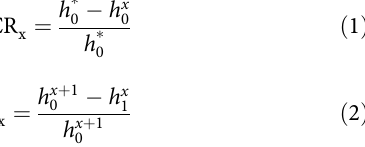
(CR) and the elastic modulus after relaxation ( E relax ). The CR is directly calculated from the difference in pellicle thickness ( h ) at each compression pro fi le compared to the starting thickness ( h 0 * ) (Eq. 1). E relax is computed using the geometric area of the pellicle (A), the compression strain at each cycle ( ε x, relax ) (Eq. 2), and the difference in the normal force during the compression step at each cycle ( Δ F x, relax ) (Eq. 3). The Poisson ratio in BC hydrogels is very close to zero 41,43 . After each relaxation step, a small amplitude oscillatory shear test was performed in the linear vis- coelastic region (as determined by the stress sweep data in Sup- plementary Fig. 8), to determine the material shear moduli ( G ’ and G ” ). The storage modulus G ’ (showing the elastic contribu- tion) is found to be always larger than the loss modulus G ” (viscous contribution) for all relaxation steps (Supplementary Fig. 7). This shows that the BC-H hydrogels exhibit pre-